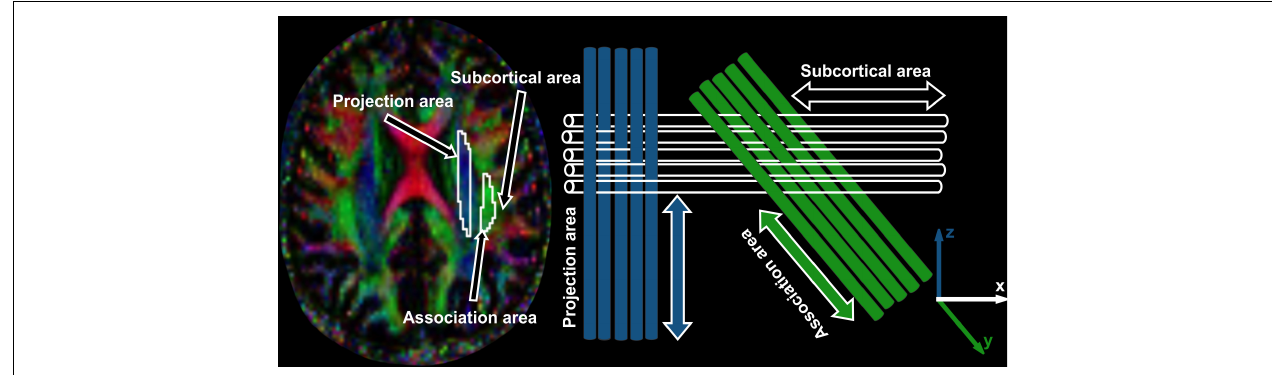
FIGURE 1 | DTI color map with ROIs placed and arrows marked are showing projection, association and subcortical areas. Schematic diagram is showing the direction of the projection fibers (blue; z -axis), association fibers (green; y -axis), and the subcortical fibers (white; x -axis).